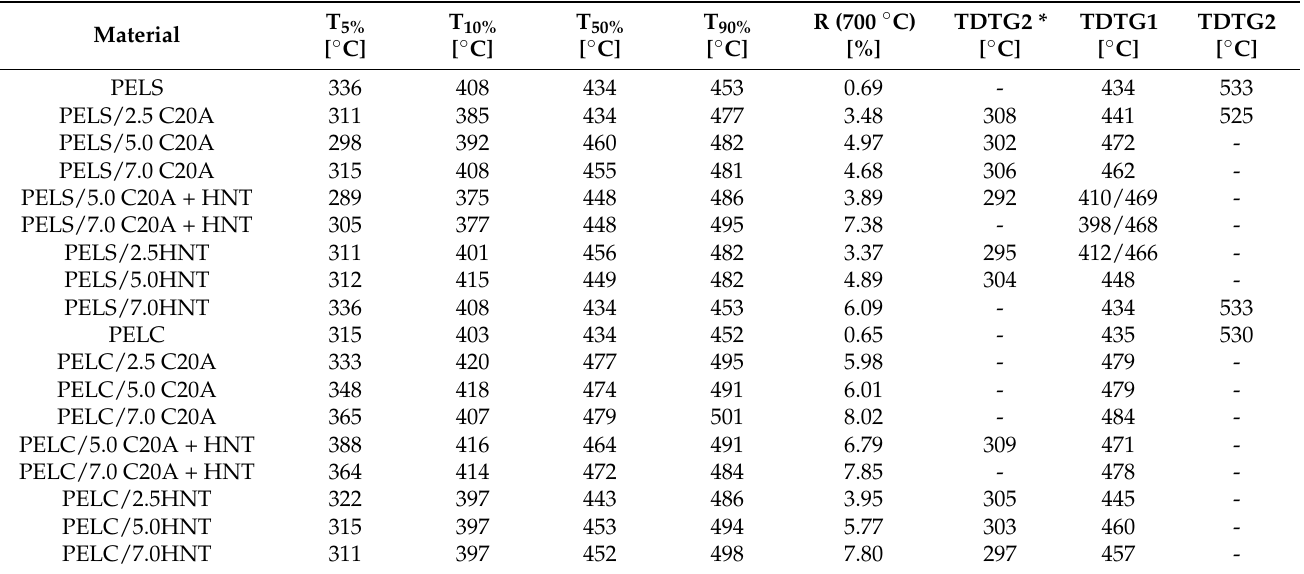
Figure 12. Thermo-oxidative stability: ( a , b ) PELS-based nanocomposites; ( c , d ) PELC-based nanocomposites. Table 5. Thermo-oxidative stability parameters for PELS-based and PELC-based